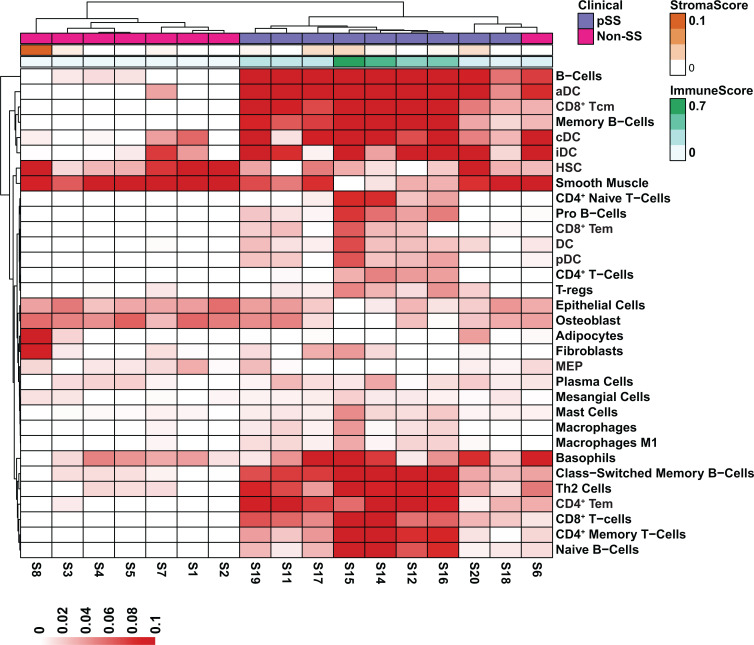
Cell Type Enrichment Analysis in pSS. Heatmap visualization of gene set enrichment scores by cell type. Scores were normalized across rows. The stroma and immune scores are displayed at the top of the heatmap. Cell types were assigned by the xCell algorithm based on the estimated enrichment of cell type signature genes in each bulk RNA-seq sample.